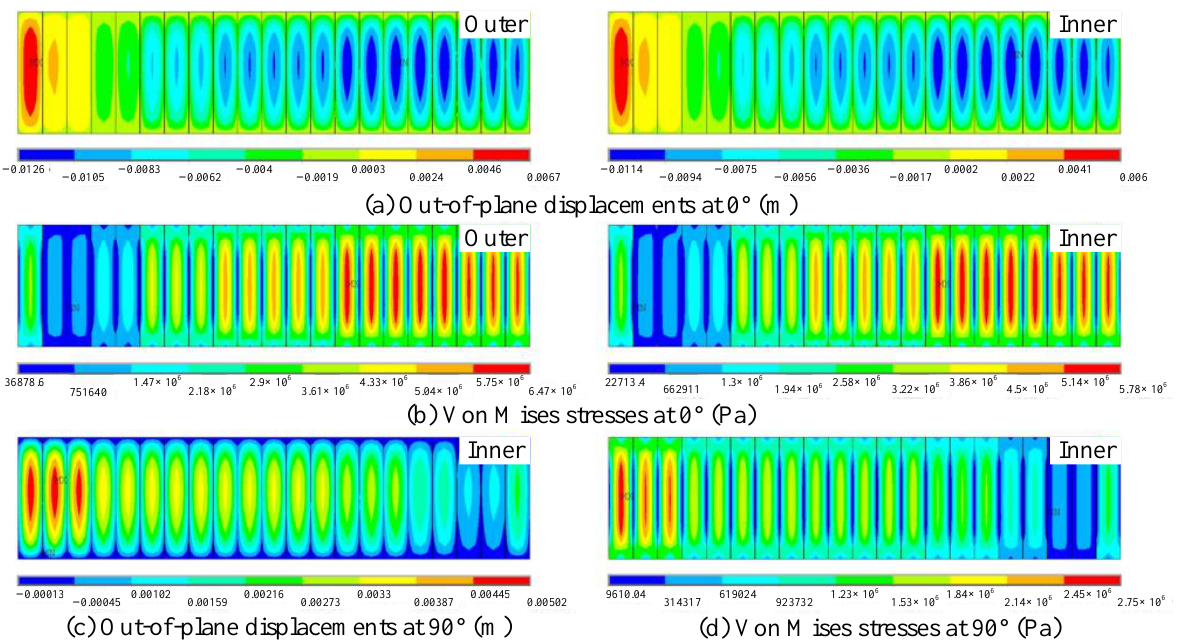
Inner(a) Out-of-plane displacements at 0° (m)